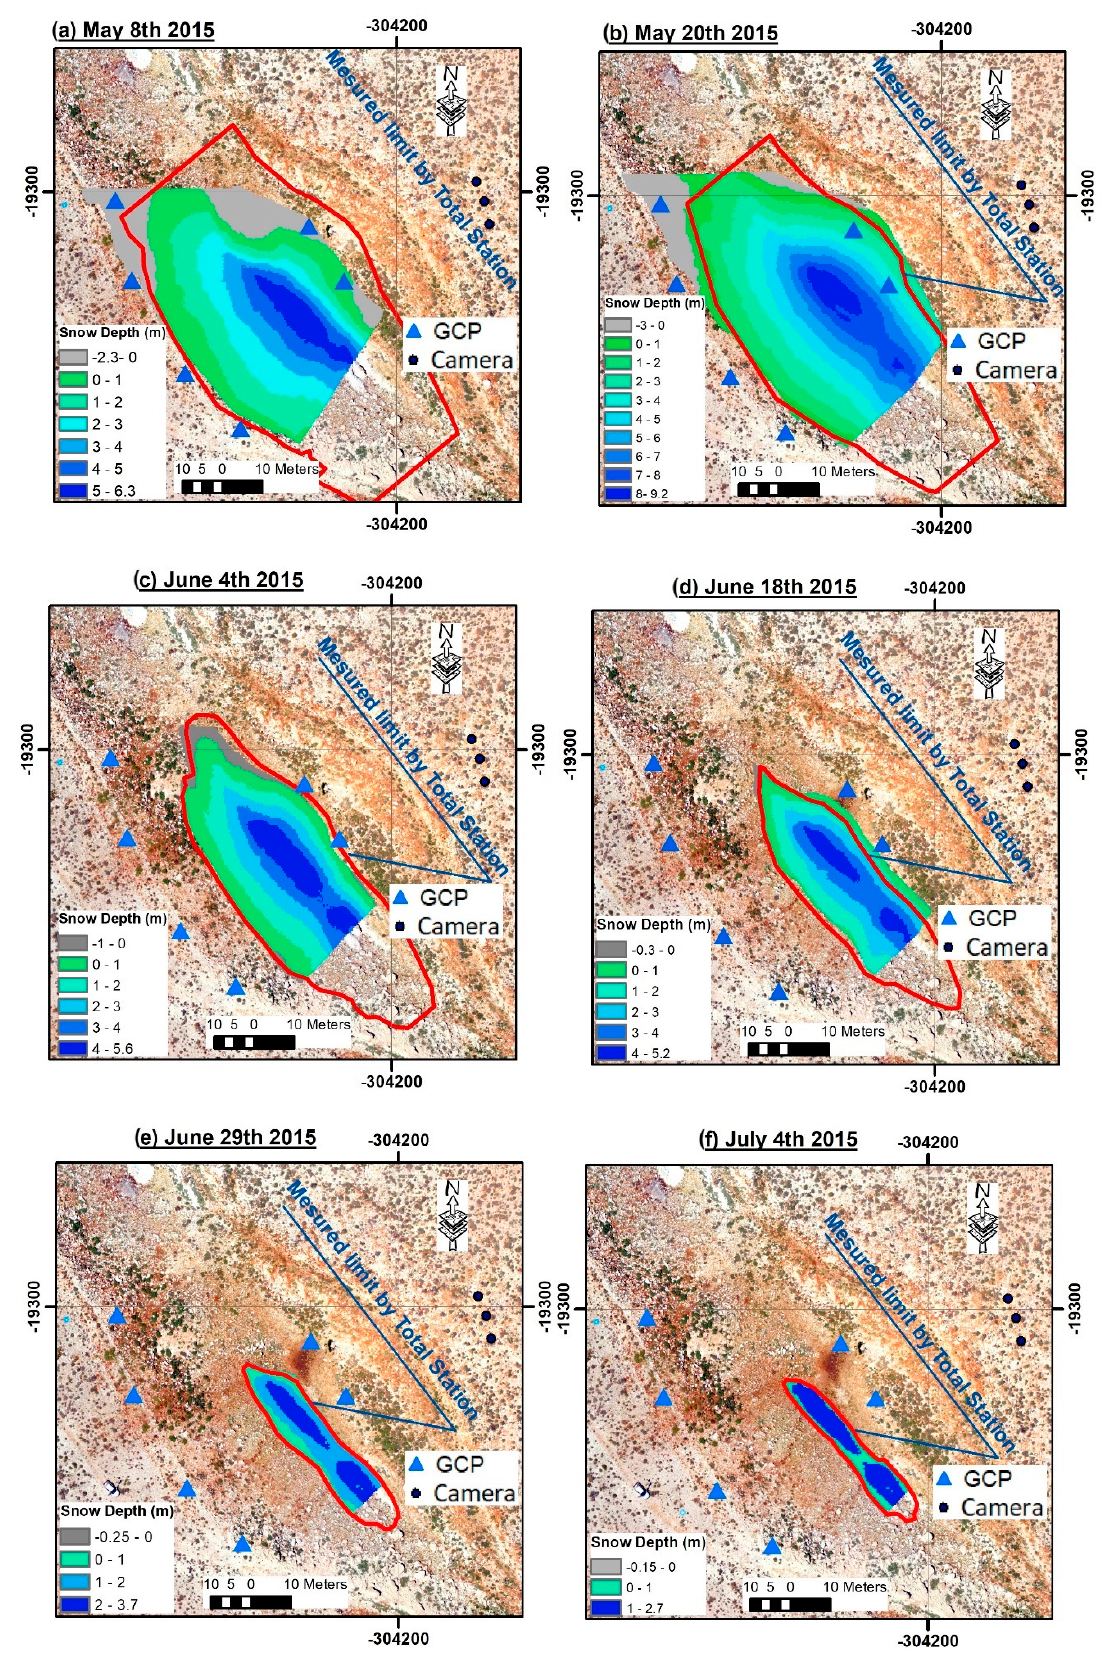
Figure A2. Snow depth maps of Exp.2.